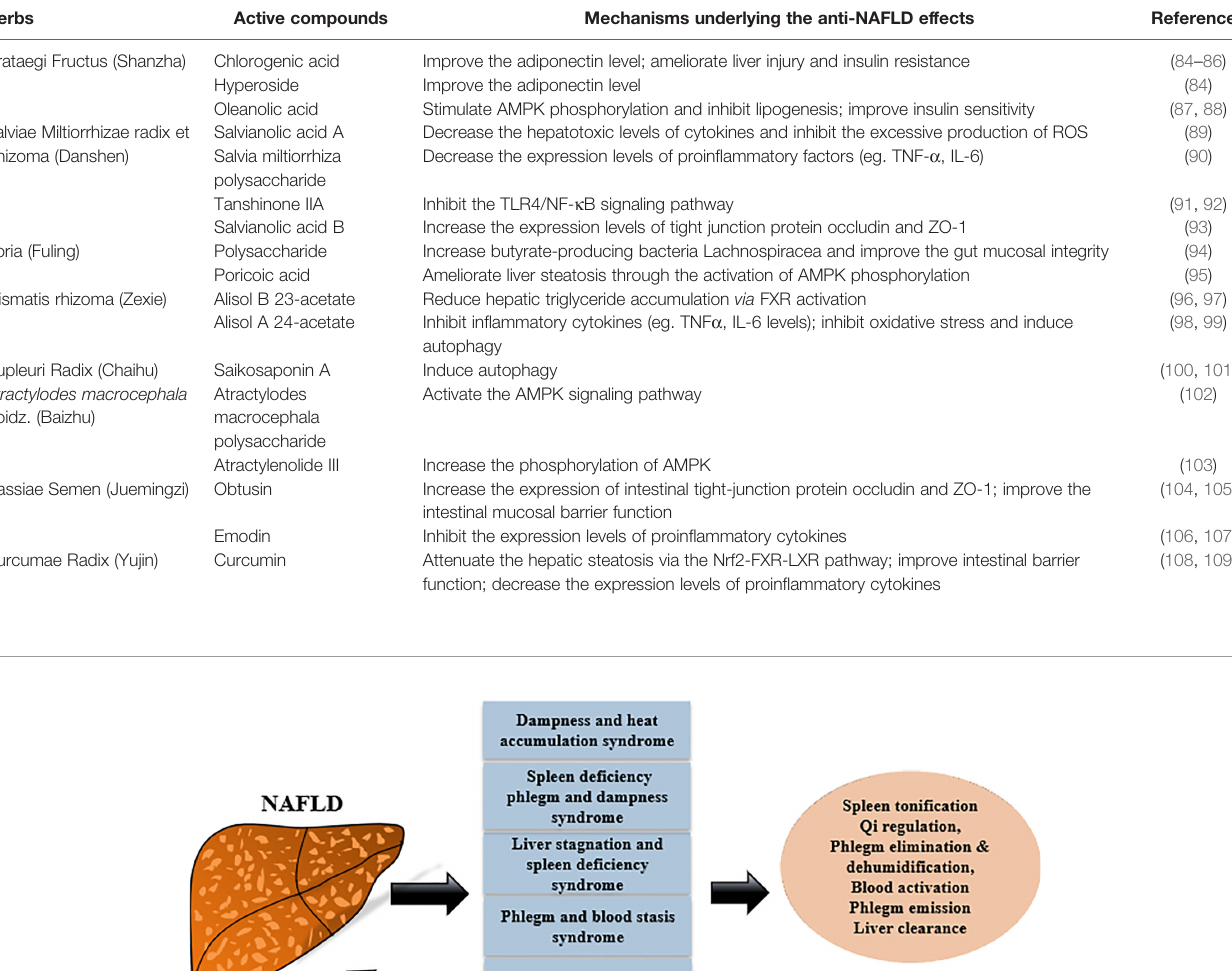
TABLE 1 | The top eight commonly used herbs and their constituting anti-NAFLD active compounds. Herbs